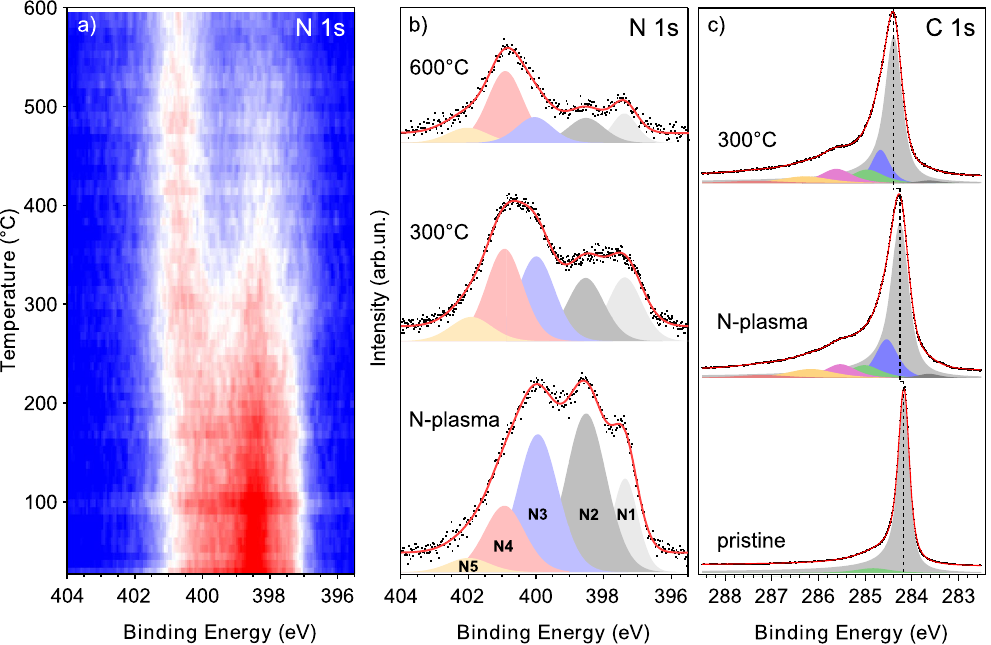
Figure 1. ( a ) Temperature-programmed XPS data as a 2D trace of the spectral intensity as a function of BE and temperature (higher to lower intensity represented by false colours from red to blue). ( b ) N 1 s spectra recorded at room temperature after plasma exposure and temperature ramps respectively up to 300 and 600 °C. The two spectra after annealing come from two distinct temperature ramps on the two samples. ( c ) C 1 s core level spectra of pristine graphene/Ir(111), after nitrogen plasma exposure, and after annealing at 300 °C. Black dots are the experimental data, the red continuous line is the fitting curve and the black dashed line is a guide for the eye. The pristine graphene C 1 s spectrum is multiplied by 0.5 for ease